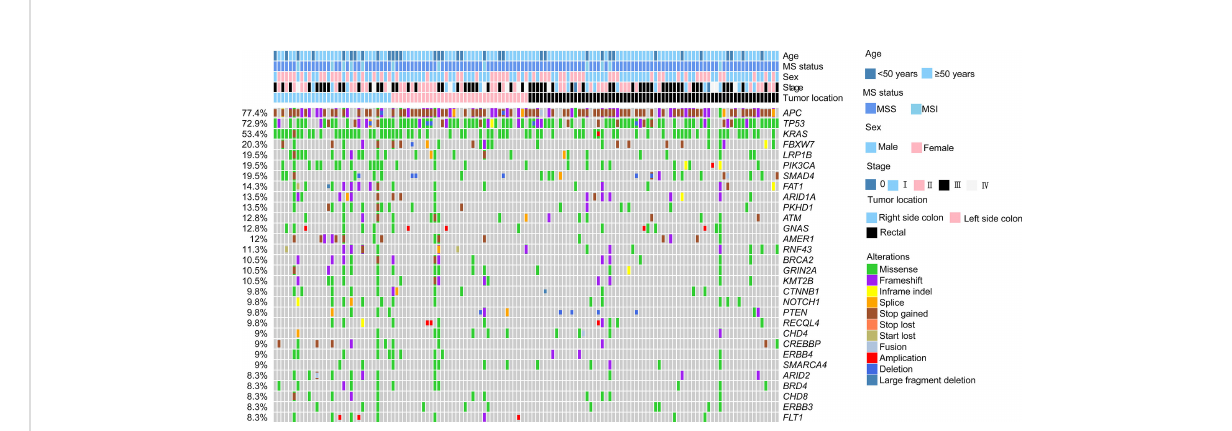
FIGURE 1 Genomic landscape of colorectal cancer patients. The clinicopathological features including age, sex, stage, tumor location, and MS status were indicated by the bar on the top. The types of alterations were indicated by different colors. Each column represented one patient.